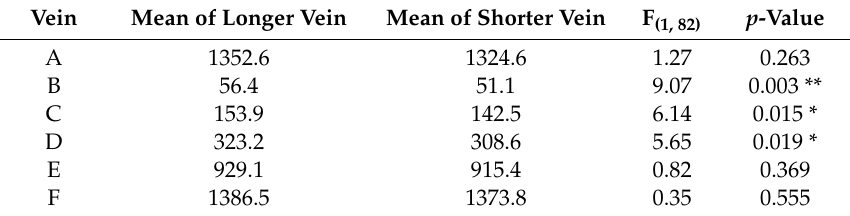
Table 4. Result of ANOVA to detect asymmetry of D. melanogaster wing veins. Vein Mean of Longer Vein Mean of Shorter Vein p